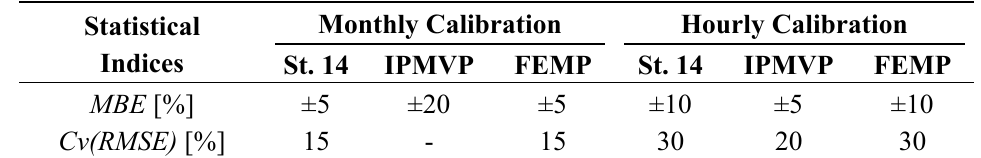
Table 2. Threshold limits of statistical criteria for calibration in compliance with